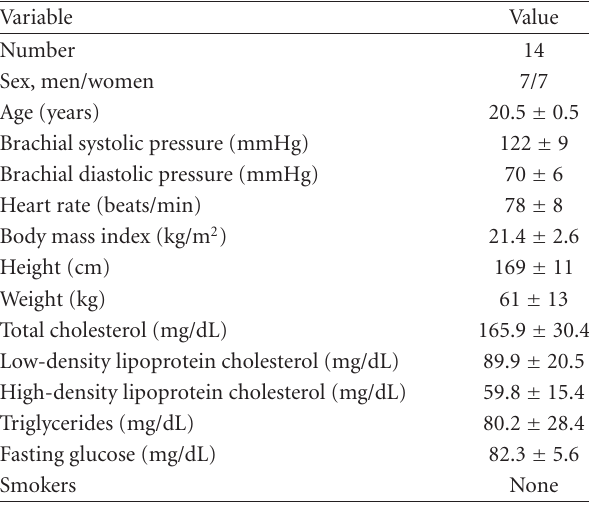
Table 1: Characteristics of the